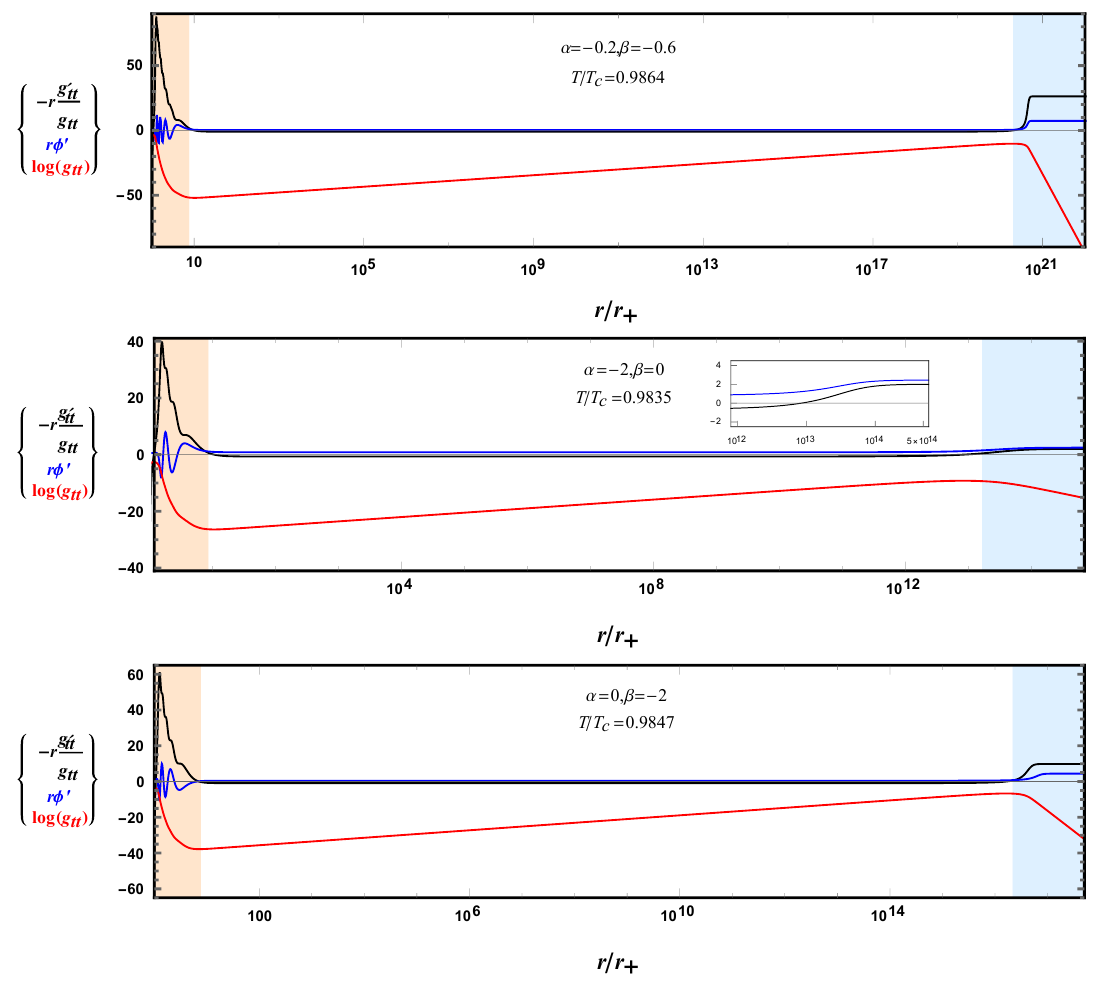
Figure 11 . An example of an interior evolution with Kasner inversion in different configurations of the massive gravity. The system evolves from the outer event horizon at r + = 1 towards the final singularity at r → ∞ . In the range 1 < r < 10 (orange shaded regime) the system goes quickly through the ER bridge collapse and Josephson oscillations epoch to the intermediate Kasner regime (white area) and stays relatively steady for an exponentially long range of r/r + with | c | > 1 (or p int < 0 ), and finally there is a Kasner inversion (blue shaded area) with | c new | > 1 (or t p t = − p int / (2 p int + 1) > 0 ). Here κ/µ = 1 in all t t